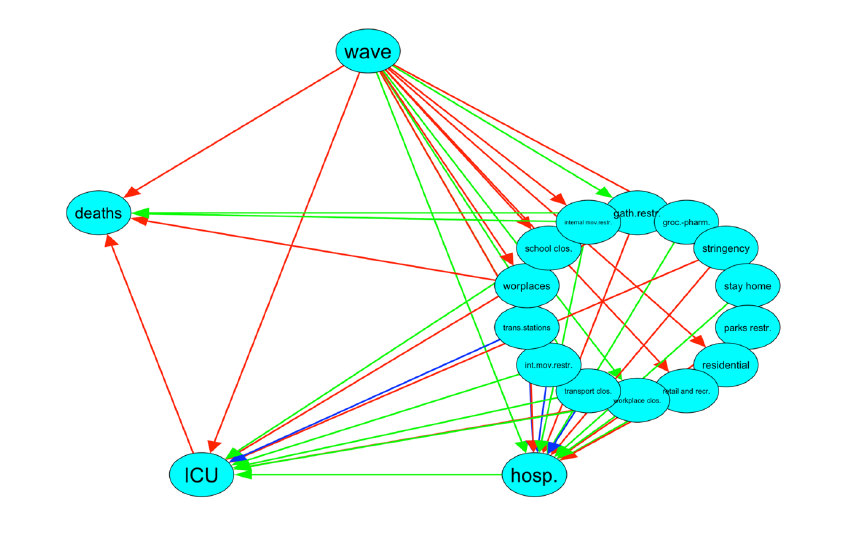
Figure 16. Comparison of lagged BNs for Italy and Israel, Italy is the target BN, Israel is the current BN. Green represents true positive, blue represents false positive and dashed red represents false negative. The resulting Hamming index is